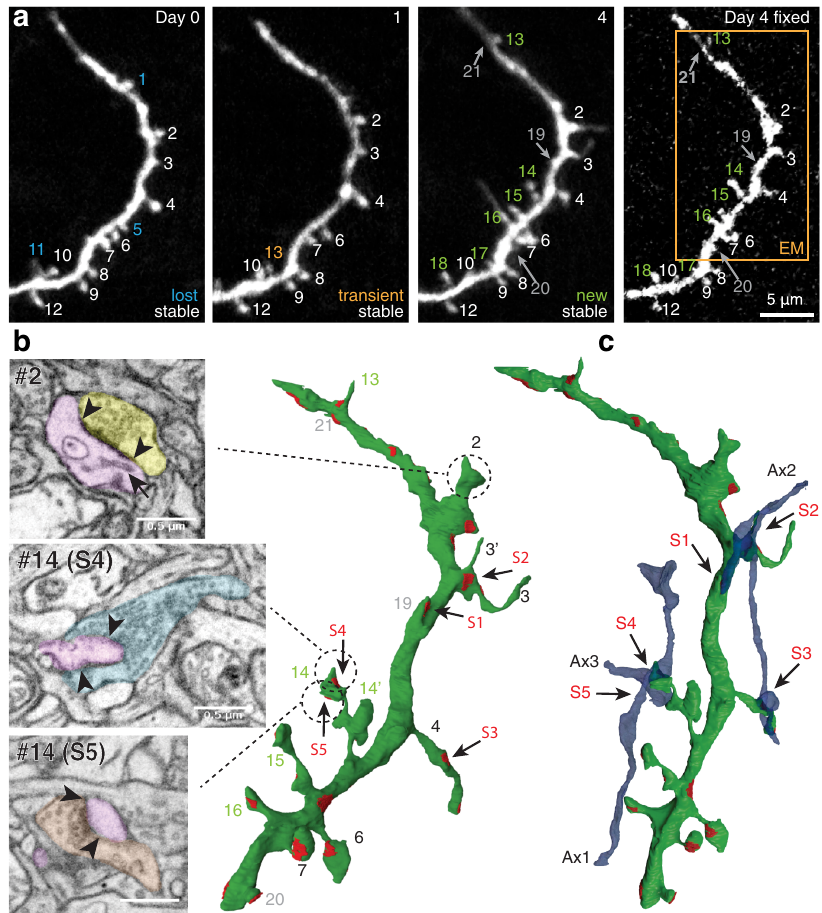
Fig. 5 Spiny VIP dendrite, imaged in vivo and reconstructed in FIBSEM. a Time-lapse images of a VIP-GFP dendritic segment that was later reconstructed using FIB/SEM. Spines are tracked and numbered over time. Stable, lost, transient, and new spines could be identi fi ed. The image on the far right depicts the same dendritic segment in a vibratome section of the perfusion- fi xed brain. All spines that were seen on the last day (day 4) in vivo could be found the fi xed material. b Middle, the FIBSEM reconstruction (green) of boxed region on the dendritic segment in ( a ). Synapses are indicated in red. All of them were asymmetric. All spines that were seen on the last day of imaging in vivo were recovered in the EM reconstruction. Grey numbers indicate spines that were obscured by the dendritic shaft in the in vivo image. Left, electron micrographs of spines 2 and 14. Presynaptic elements are in yellow, blue and orange; postsynaptic elements in pink. Arrowheads demarcate the synaptic contacts. The arrow in spine 2 indicates ER. Spine 14 contained two separate synapses on its head. Some spines had a compound morphology (e.g., spine 3, 14 and 15) or various thickenings (e.g., spine 2). c Reconstructions of three presynaptic axons (blue) showing the compound connectivity of the reconstructed dendrite. Upper panel, an axon that has 3 synaptic contacts in total, 2 with different spines (S1 and S3) and one on the shaft (S2). Lower panel, two different axons that contact the same spine (spine 14, S4 and S5). Note that spine 14 was newly